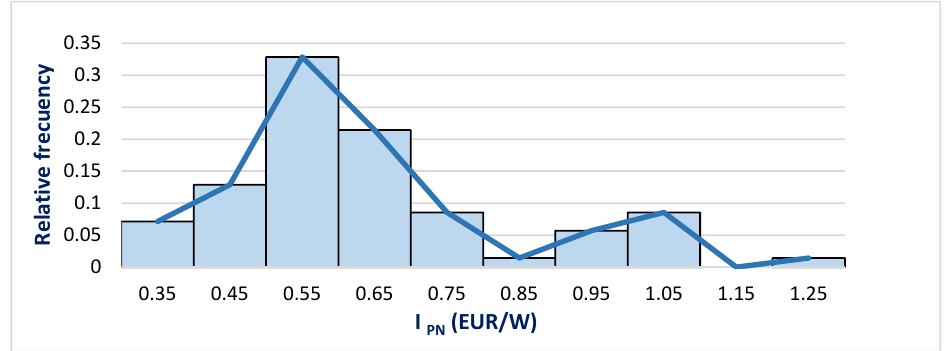
I (EUR/W) I (EUR/W) PN PN . . 𝐼𝐼 𝑃𝑃𝑃𝑃 𝐼𝐼 𝑃𝑃𝑃𝑃 (EUR/W) is defined as the ratio between the global (EUR/W) is defined as the ratio between the global 𝐼𝐼 𝑃𝑃𝑃𝑃 𝐼𝐼 𝑃𝑃𝑃𝑃 , the peak power is higher than , the peak power is higher than in- in- 𝑂𝑂 𝑃𝑃 𝑂𝑂 𝑃𝑃 indicator. In fact, the values of indicator. In fact, the values of 𝐼𝐼 𝑃𝑃𝑃𝑃 𝐼𝐼 𝑃𝑃𝑃𝑃 are between are between 𝐼𝐼 𝑃𝑃𝑃𝑃 𝐼𝐼 𝑃𝑃𝑃𝑃 𝐼𝐼 𝑃𝑃𝑃𝑃 𝐼𝐼 𝑃𝑃𝑃𝑃